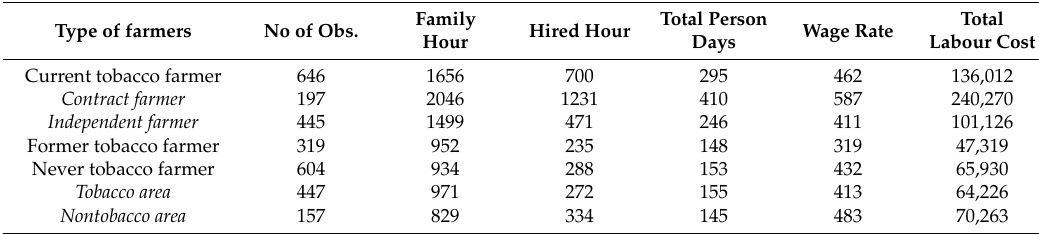
Table 8. Cost of labour per household by source and farmer